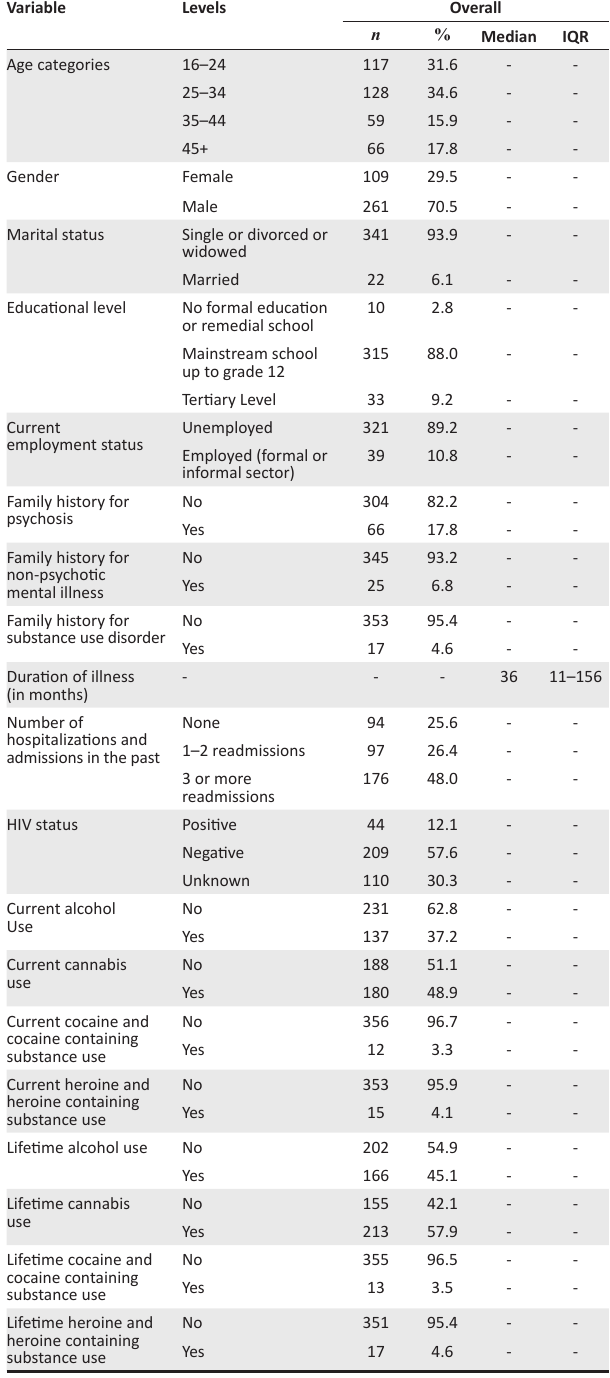
TABLE 1: Socio-demographic and clinical variables of people admitted with schizophrenia spectrum and other psychotic disorders.